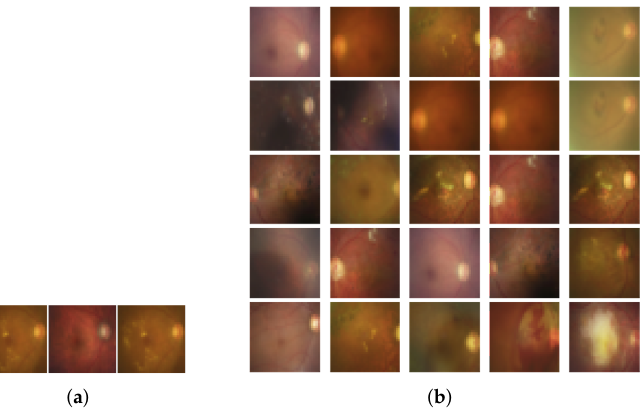
Figure 18. Examples of misclassification of Classes 1 and 2 by the SVM-RBF-Kernel. ( a ) Class 1; ( b ) Class 2.